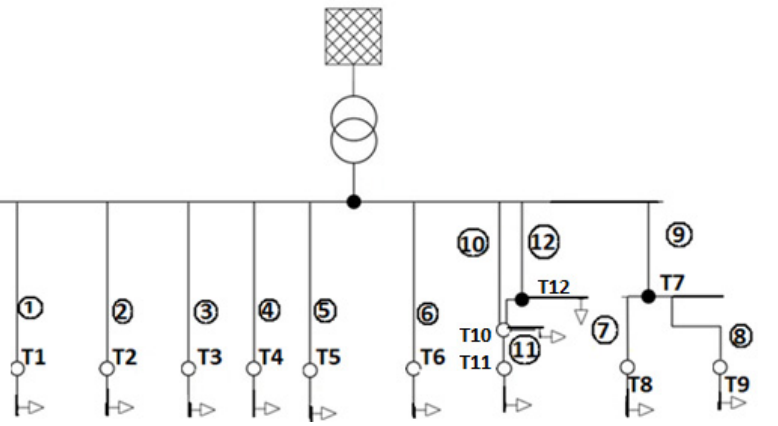
Figure 4. Line diagram showing layout of network 3. The network is in a star topology centered at the terminal connected to the secondary winding of the transformer.